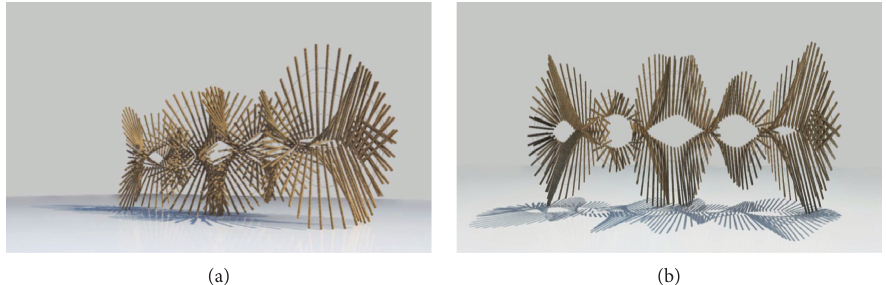
Figure 9: Implementation structure of butterfly flying movement. Concept: wings in flight (source: drawing by the research team).